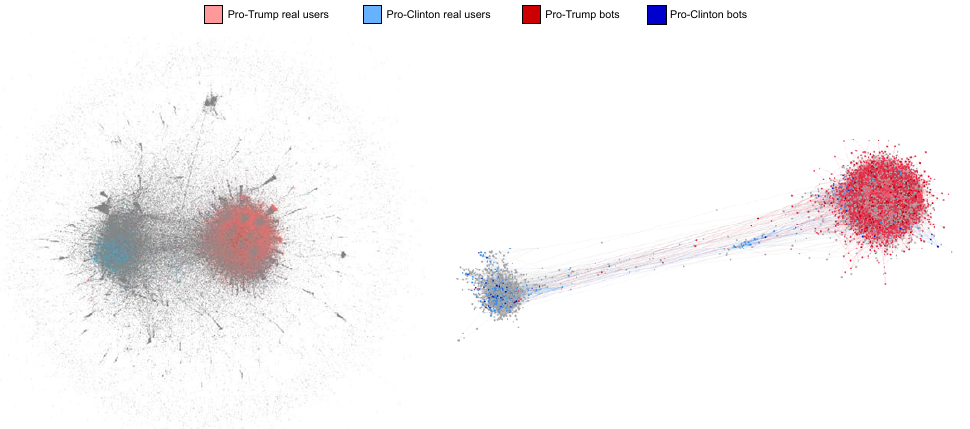
Figure 3. Visualization of the diffusion process on the repost graph. The total graph (on the left ) and the sampled graph (on the right ) are shown, whose nodes are colored according to their